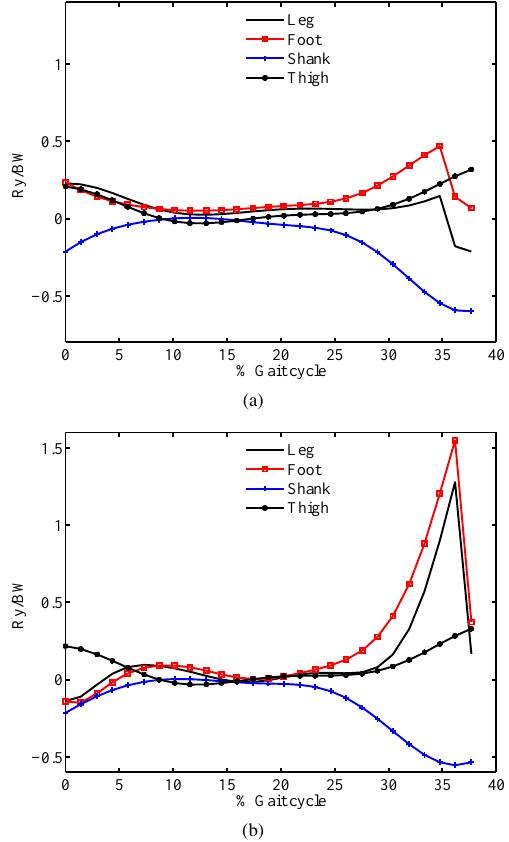
Figure 8. Contributions from foot, shank and thigh of the stance leg and sum of all three (Leg) to GRFy in SS phase as a fraction of body weight with (a) AFROS and (b) FROS models for the foot. (Gait cycle starts at toe-off of the other leg, that is, at the beginning of SS.)